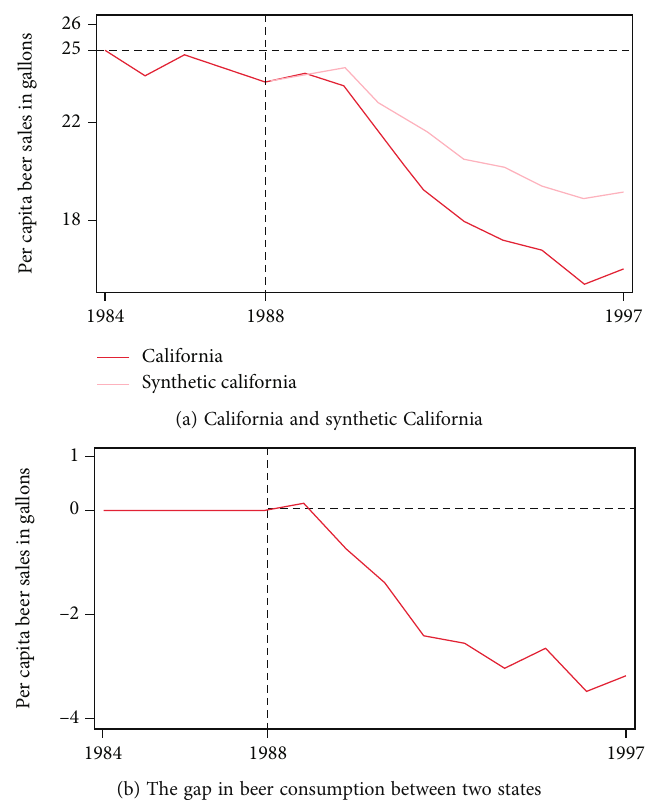
Figure 1: The e ff ect of California ’ s Proposition 99 on local beer consumption.